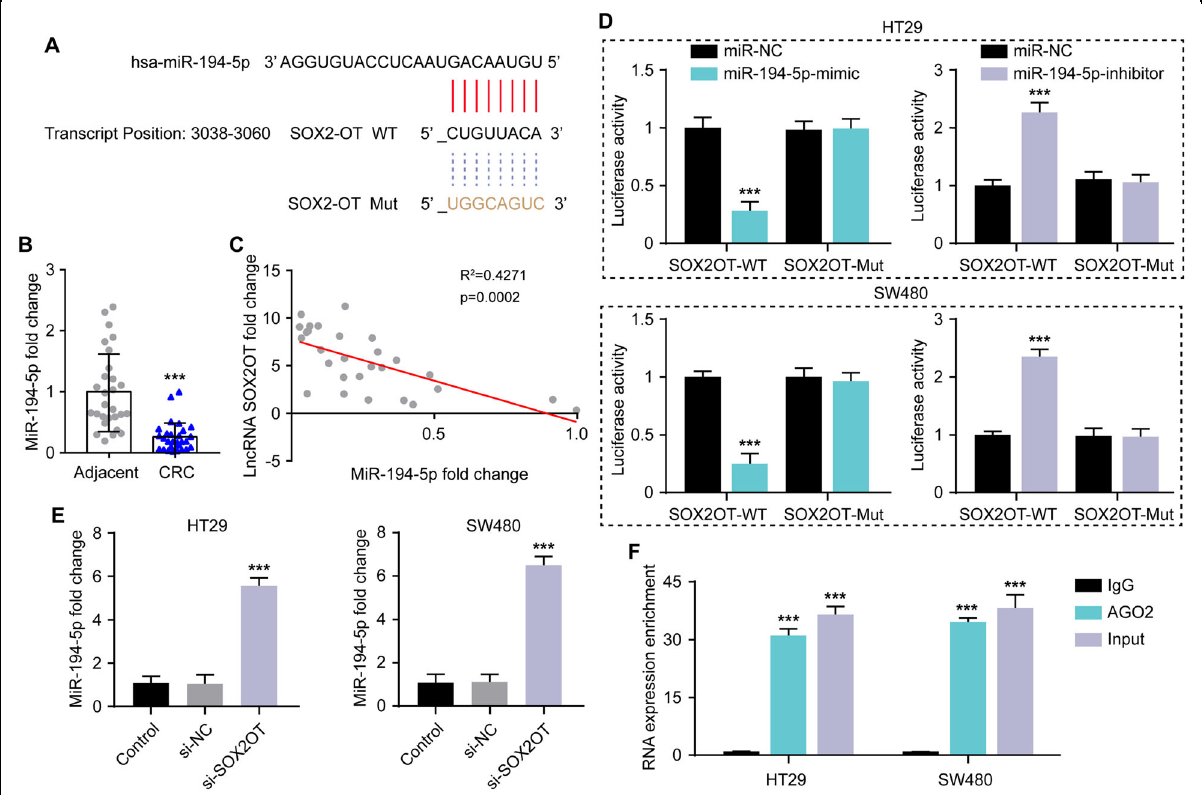
Fig. 4 SOX2OT targeted miR-194-5p directly in CRC. A Putative binding site between SOX2OT and miR-194-5p through starBase v2.0. online software. B qRT-PCR was performed to determine miR-194-5p expression in 28 pairs of CRC tissues and adjacent non-tumor tissues, *** P < 0.001 vs. adjacent. C Pearson ’ s correlation analysis showed an inverse correlation between SOX2OT and miR-194-5p in CRC tissues. D Luciferase reporter assay for analysis of the interaction between SOX2OT and miR-194-5p in HT29 and SW480 cells, *** P < 0.001 vs. miR-NC. E Relative expression levels of miR- 194-5p after silencing of SOX2OT in HT29 and SW480 cells by qRT-PCR, *** P < 0.001 vs. miR-NC. F SOX2OT enrichment in HT29 and SW480 cells is presented as fold enrichment in Ago2 relative to IgG immunoprecipitates, *** P < 0.001 vs. miR-NC. Data were expressed as mean ± SD. All experiments were repeated three